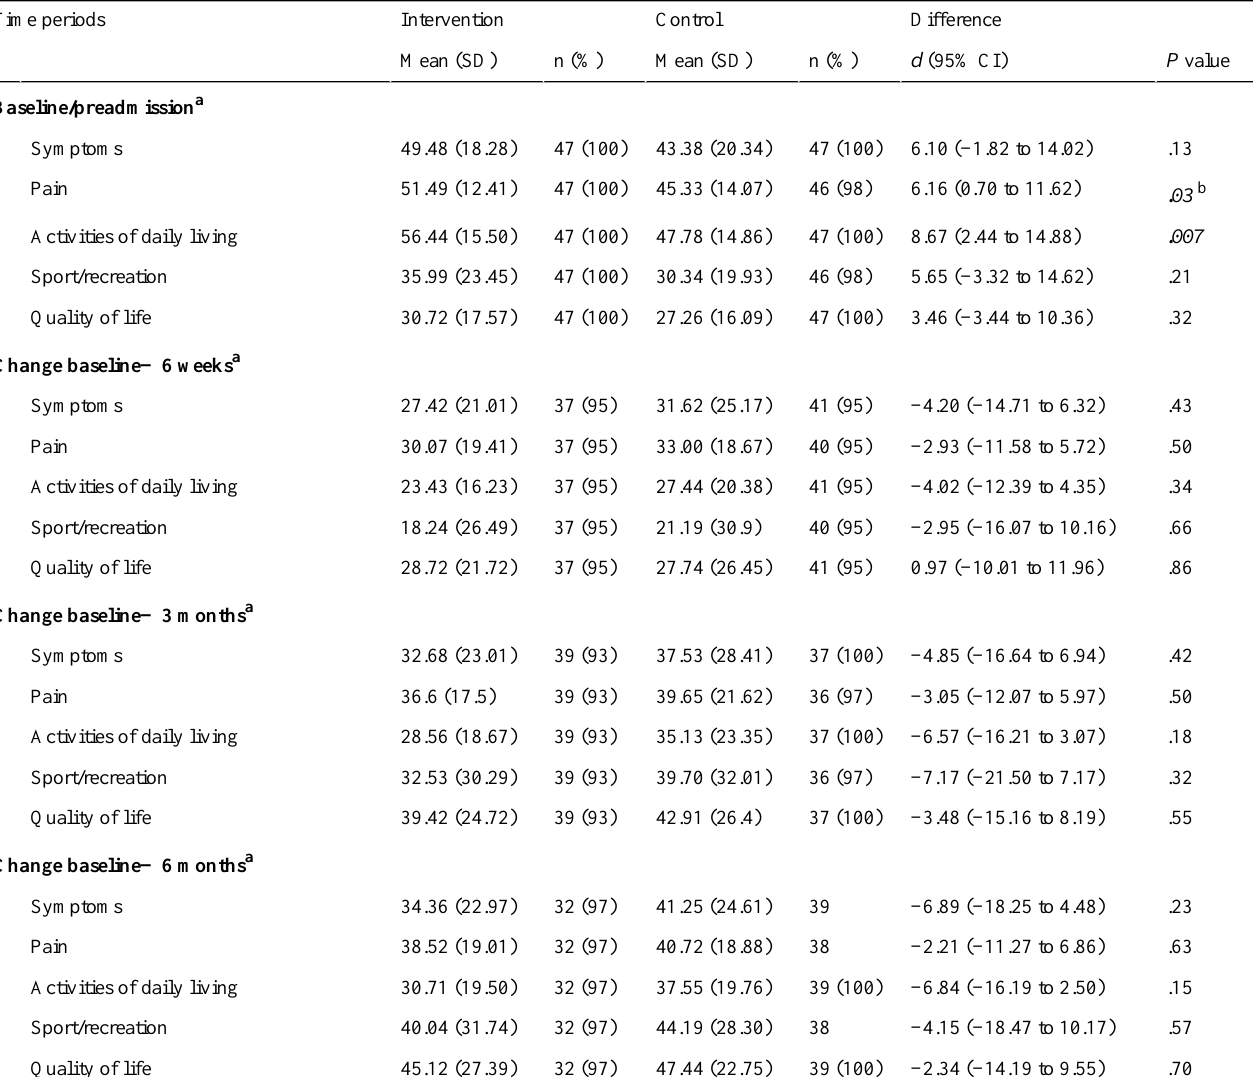
Table 2. Primary outcome assessment Hip Dysfunction and Osteoarthritis Outcome Score. DifferenceControlInterventionTime